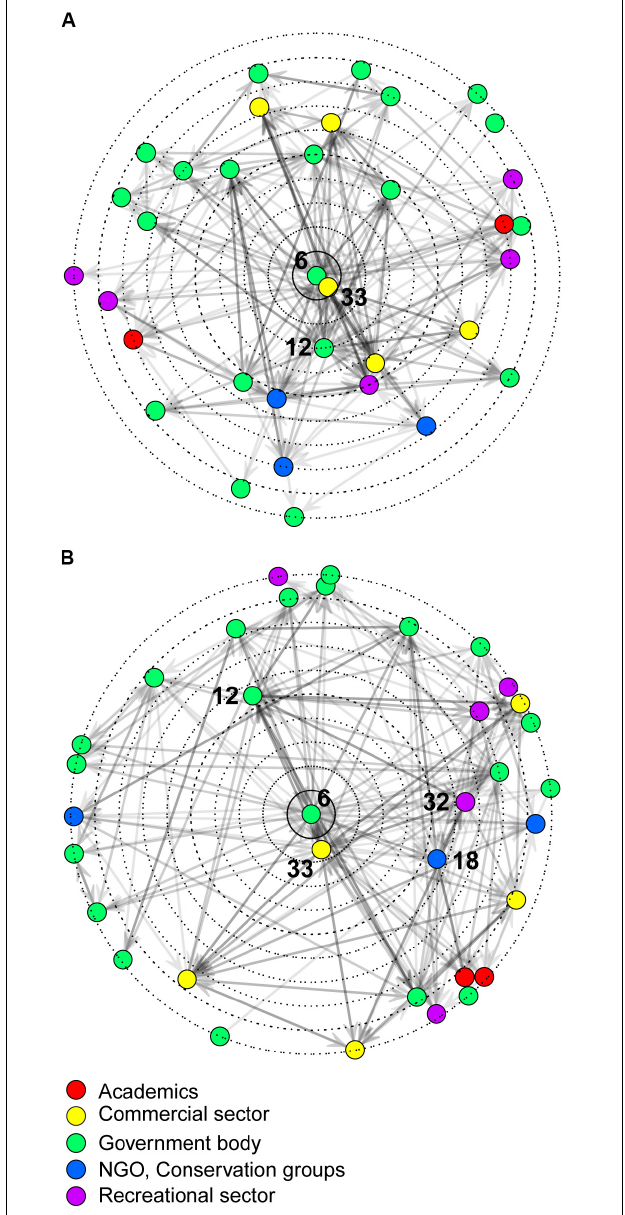
FIGURE 2 | Target plot of degree centrality (A) and betweenness centrality (B) for individuals forming the closed population network. Numbers indicate individuals with higher centrality and betweenness, These appear near the center of the